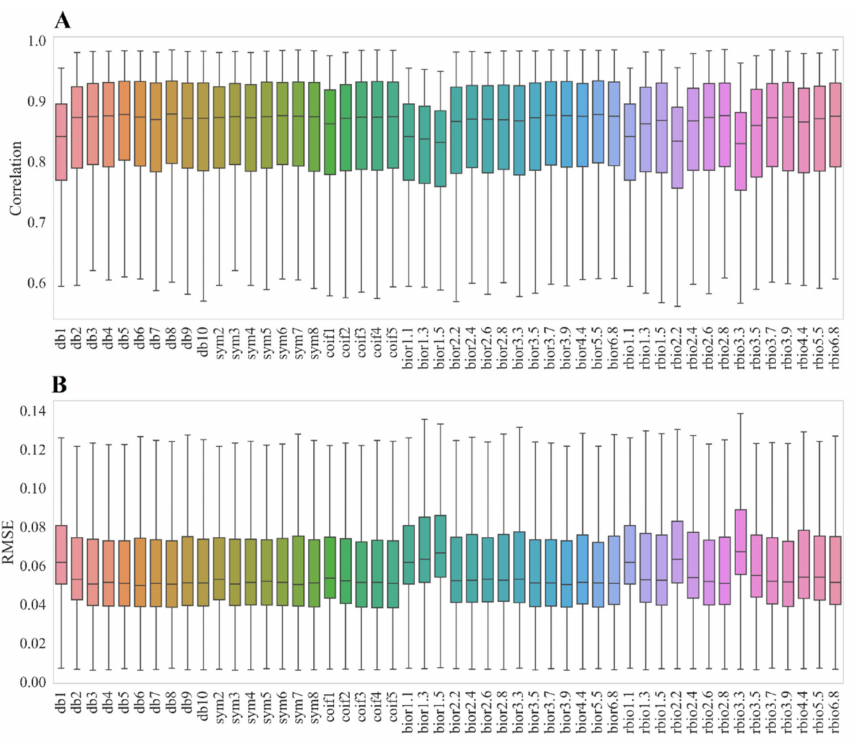
Figure 5. Wavelet denoising results: boxplots of the cross-correlation (CC, panel ( A )) and root mean square error (RMSE, panel ( B )) values between observed and denoised NDVI time series by using different mother wavelets. The AVHRR sensor was selected as the sample sensor due to its larger dataset (2000–2020). The wavelet “db9” exhibited better RMSE (0.096) and cross-correlation (CC = 0.741) compared to others in each box. In each box, the central mark is the median, and the bottom and top box edges indicate the 25th (Q1) and 75th (Q3) percentiles, respectively; the whiskers extend to the min/max data